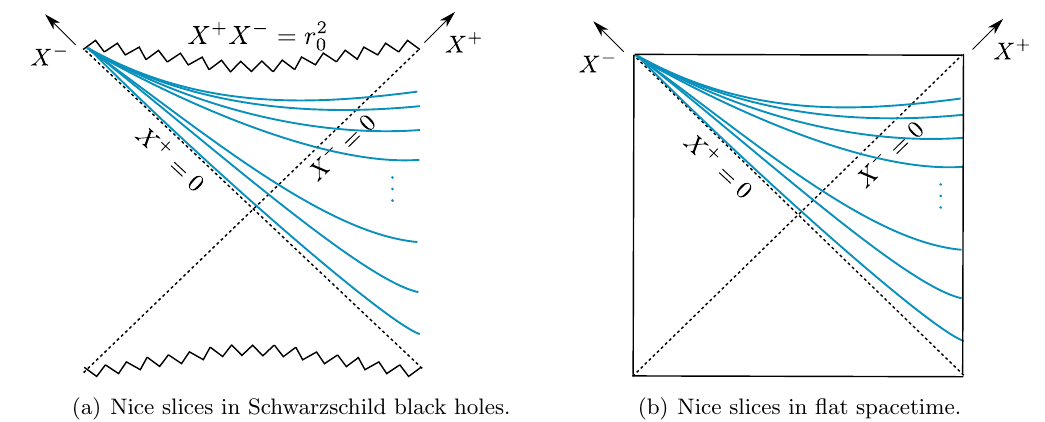
Figure 1 . Depicted in blue is a nice slicing of (a) Schwarzschild black hole and (b) (cid:13)at